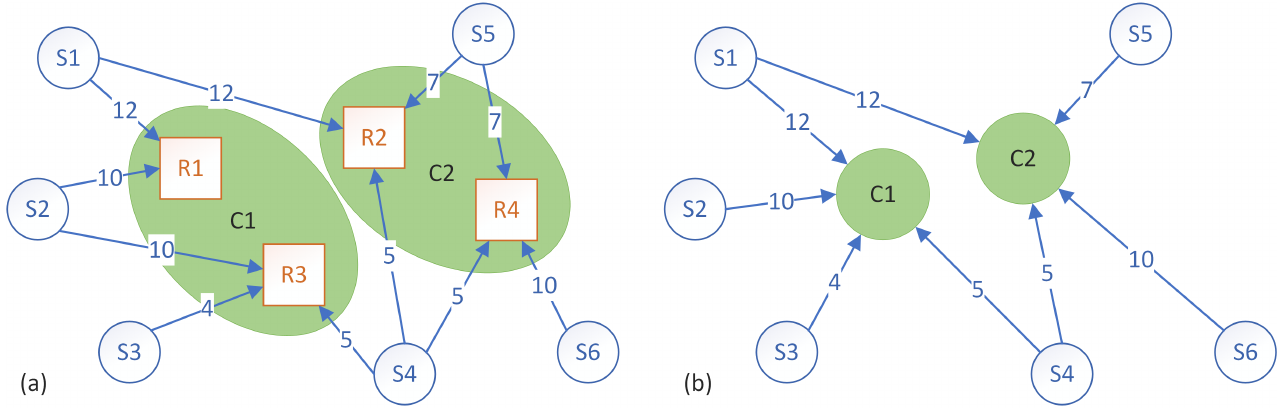
Figure 3. Example of clustering rules for the graph from Figure 2. ( a ) There are two clusters: C 1 with rules R 1 and R 3 and cluster C 2 with rules R 2 and R 4 . ( b ) The formed clusters receive the data only once from the connected sensors ( S ).